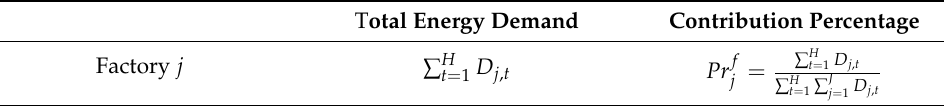
Table 3. Contribution percentage for each